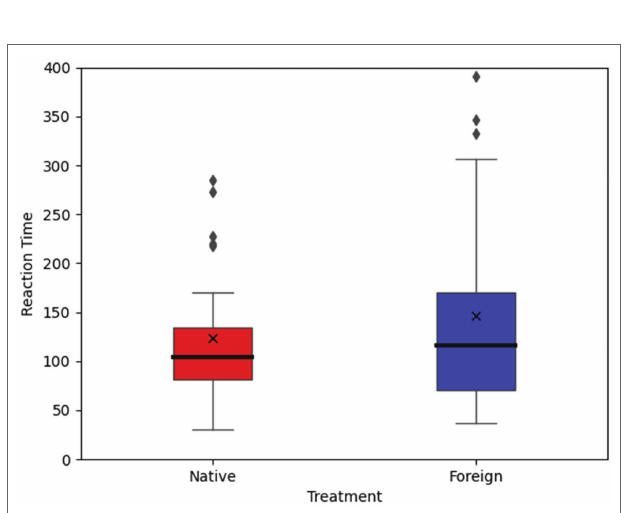
FIGURE 3 | Total reaction time of